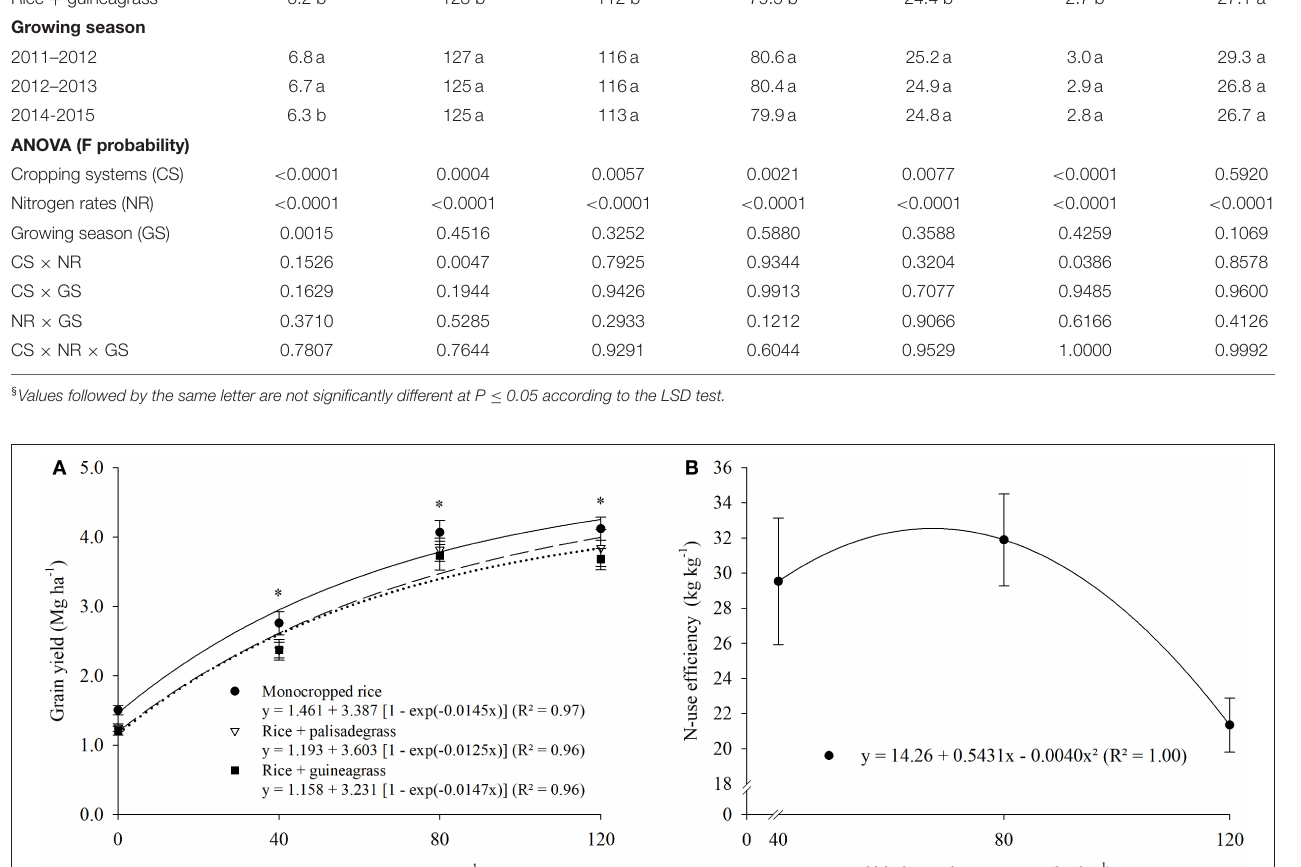
sidedress N rate on grain yield did not differ among cropping ( Figure 3A ), grain protein (11.6%) was greatest at 145 kg N ha − 1 ( Figure 3B ), and milled rice productivity (3.5 Mg ha − 1 ) was greatest at 165 kg N ha − 1 ( Figure 3C ).